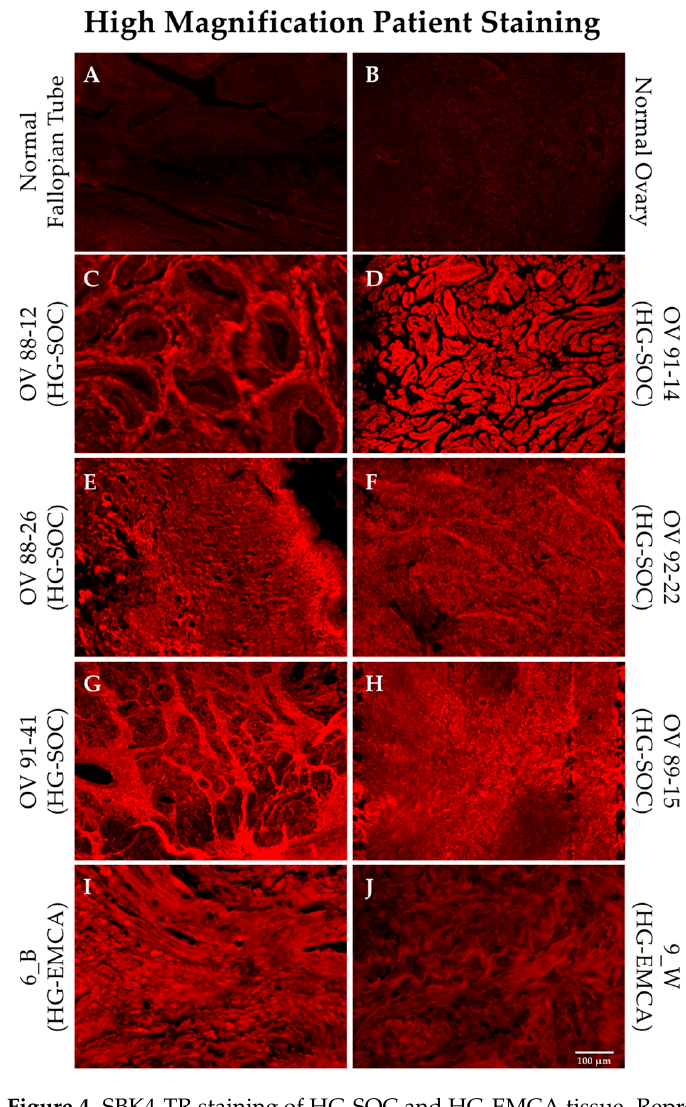
Figure 4. SBK4-TR staining of HG-SOC and HG-EMCA tissue. Representative tissue sections from patients with HG-SOC (panels C – H ) and HG-EMCA (panels I , J ) are shown stained with SBK4-TR and are compared with normal tissue sections stained with SBK4-TR (panels A , B ). Scale bar = 100 µm.